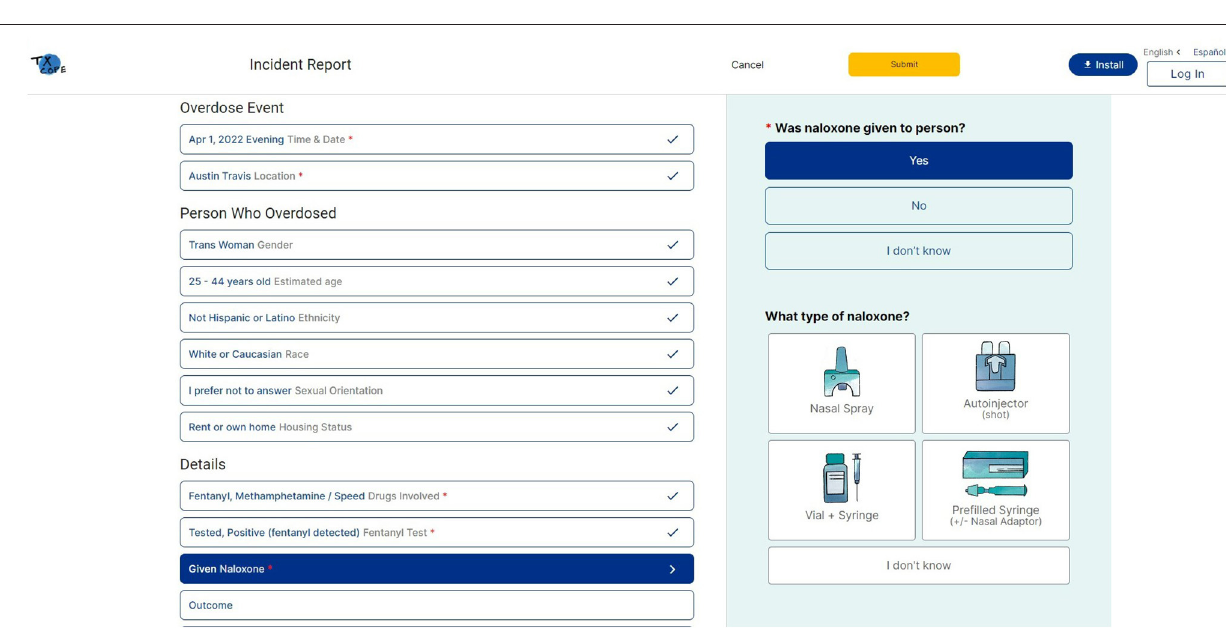
FIGURE 3 | TxCOPE overdose incident report